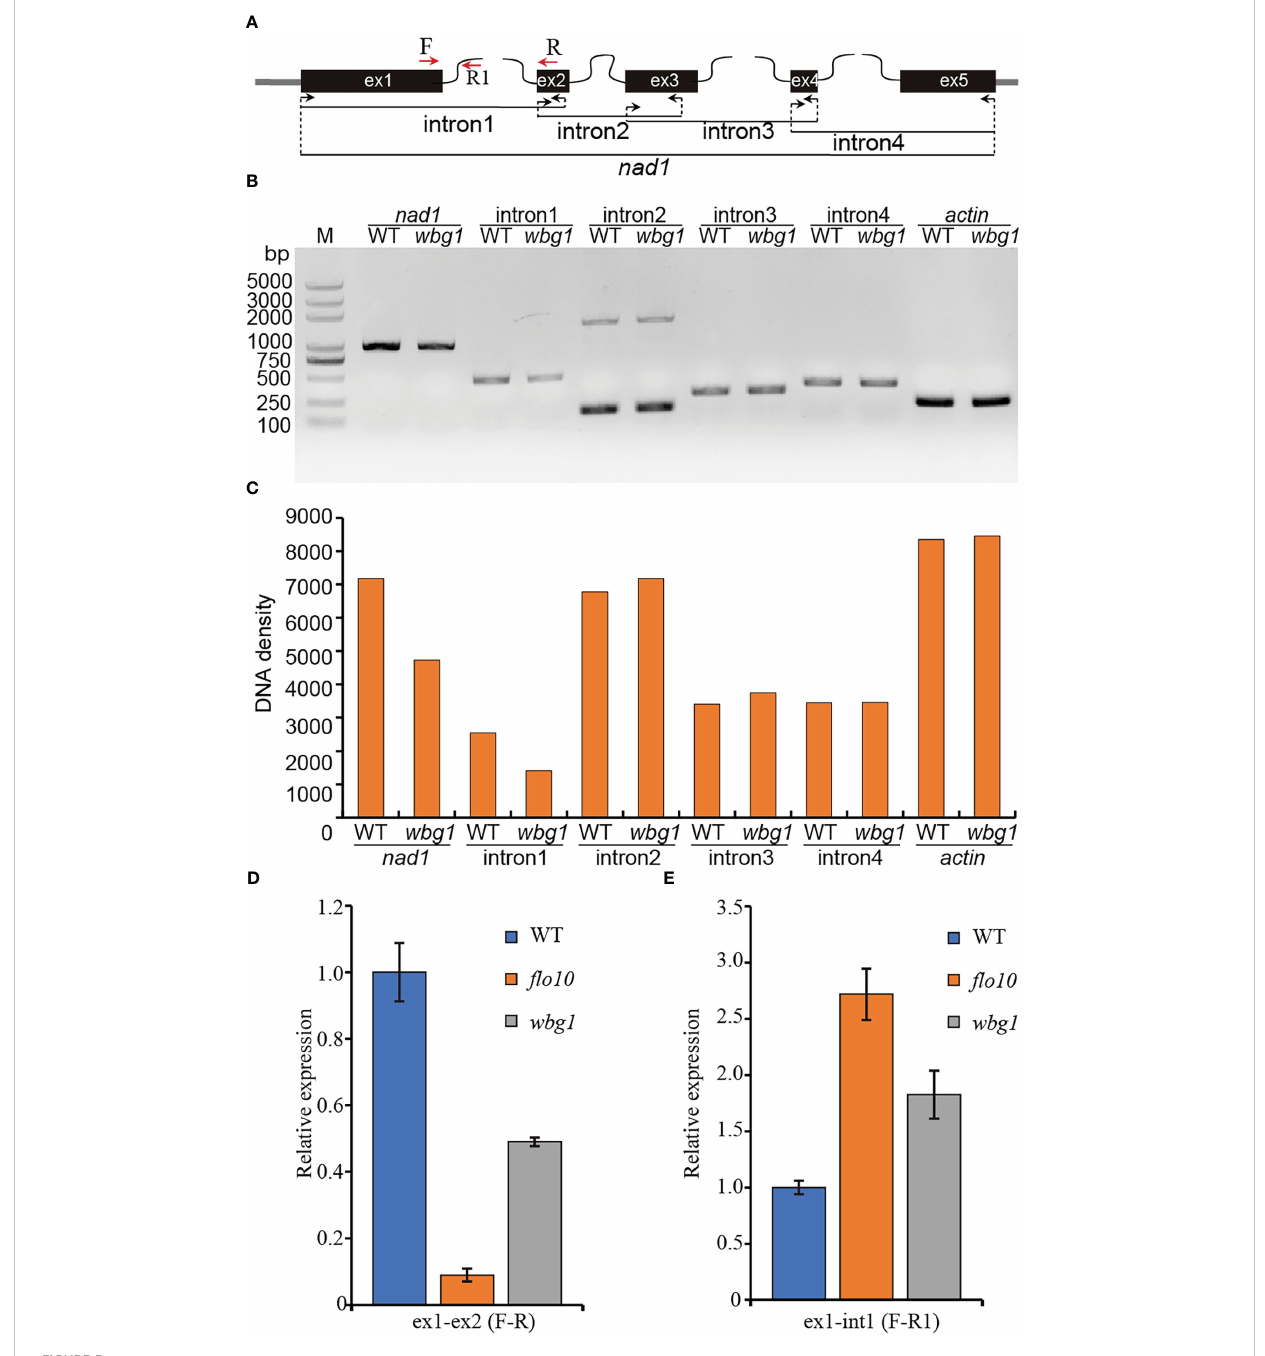
FIGURE 5 Splicing ef fi ciency analysis of nad1 intron 1 in wbg1 . (A) Schematic representation of the rice nad1 gene. (B) Reverse transcription polymerase chain reaction (RT-PCR) analysis of nad1 intron 1, 2, 3, and 4 splicing events in wild type (WT) and wbg1 . The ampli fi ed fragments are indicated in panel (A) The rice Actin gene was used as an internal control. (C) DNA density of the ampli fi ed fragments in (B) was quanti fi ed using ImageJ software. (D, E) Quantitative RT-PCR measuring the splicing ef fi ciency of nad1 intron 1 and nad1 exon 1 precursor. The PCRs were performed with the primer pairs indicated in panel (A) RNA was extracted from WT and wbg1 grains at 9 days after fl owering (DAF). Representative results from three biological replicates are shown. Values are all mean ± standard deviation